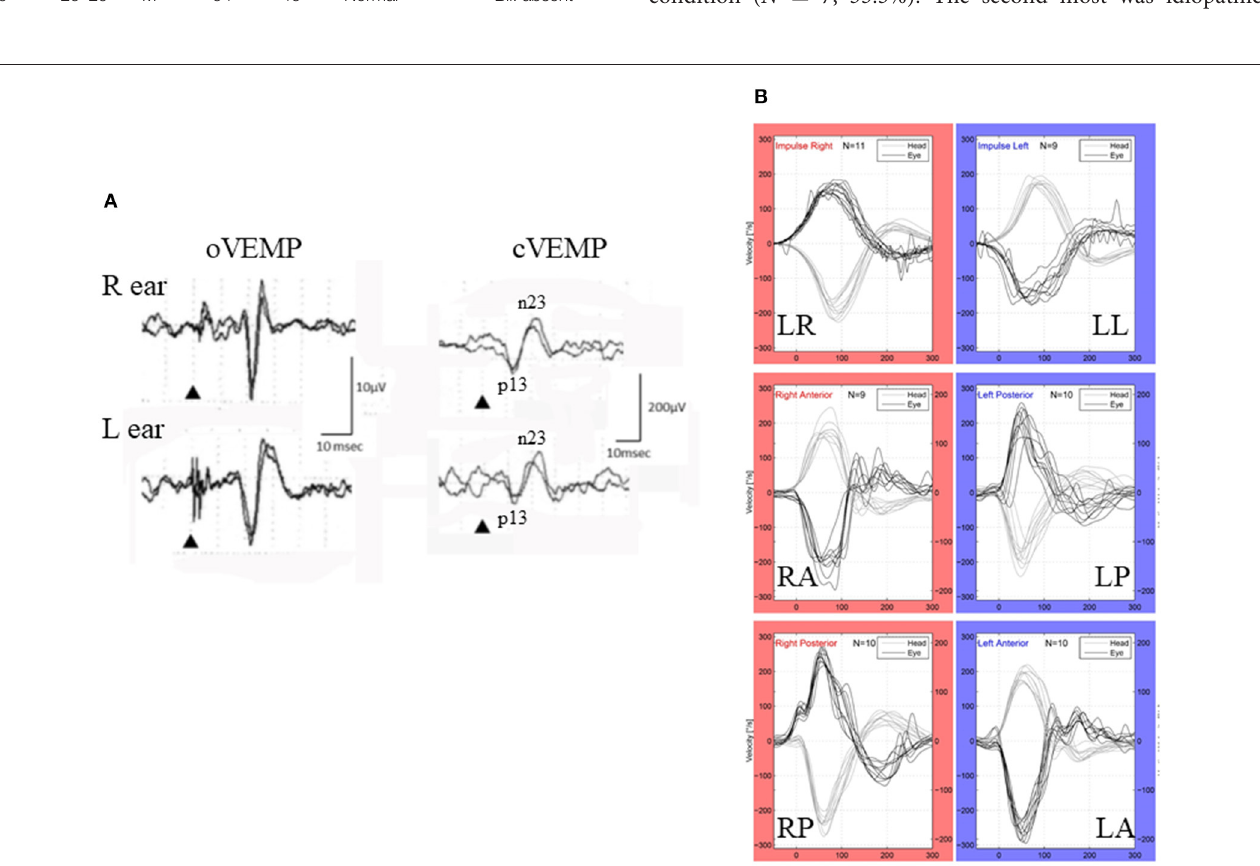
FIGURE 1 | VEMP and vHIT (patient # 9, 25–29-year-old-male). (A) cVEMP and oVEMP. While he had normal cVEMP on both sides (right), he showed absence of oVEMP on both sides (left). Although he showed some positive-negative biphasic deflections with long latencies ( > 20ms), they were not regarded as N1-P1 of the vestibular origin because of their reversed polarity and long latency. (B) vHIT. He showed normal responses to all the canals.